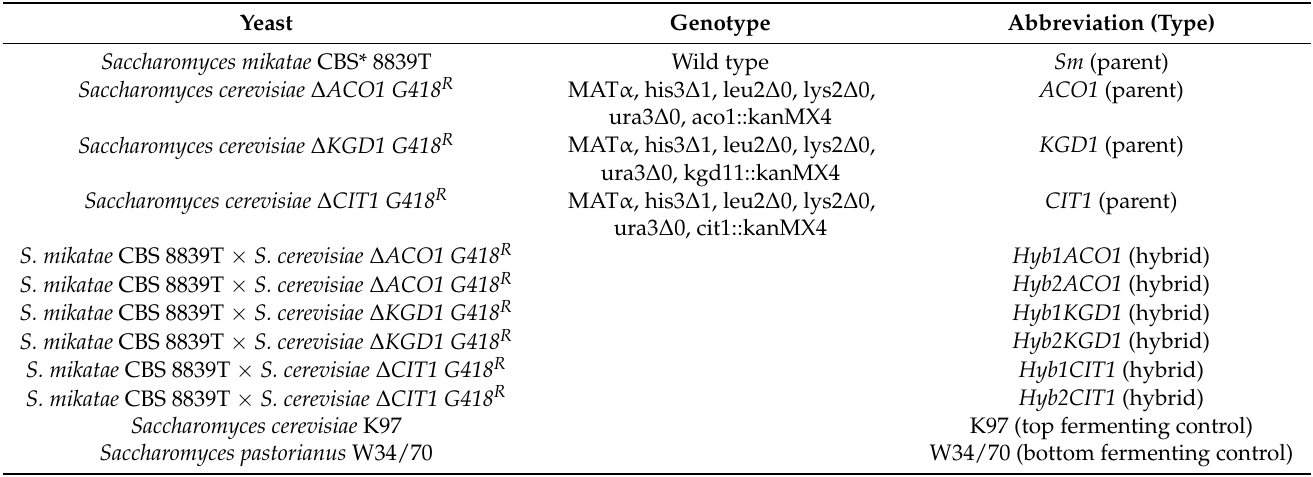
Table 1. List of hybrids, their parents and brewer ´ s controls used in this work.